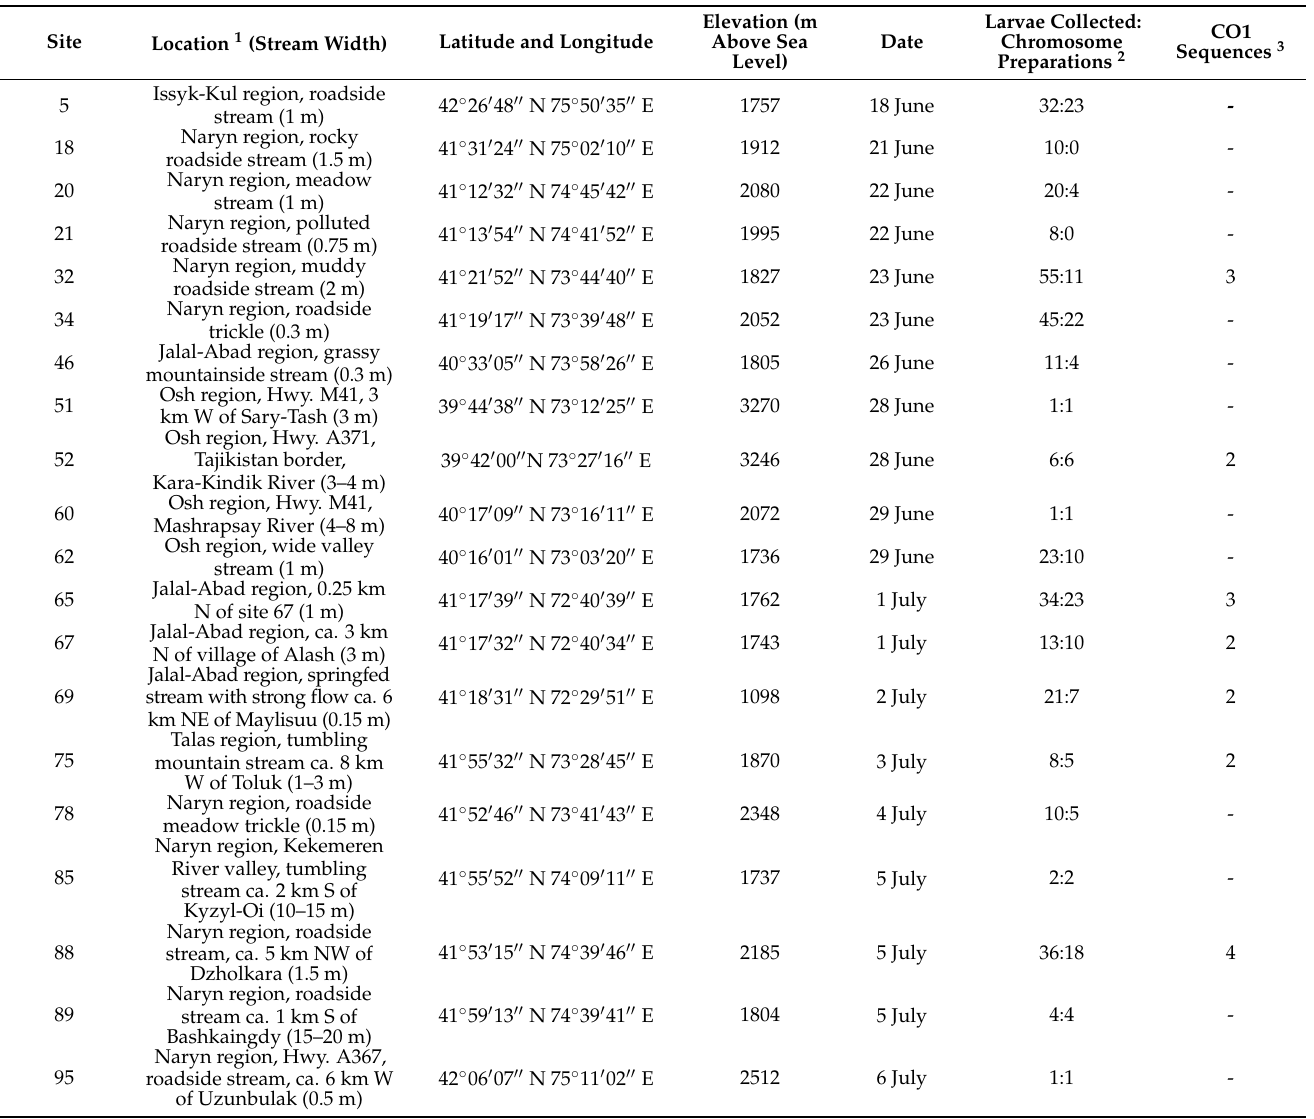
1 Distances are along straight lines. 2 Number of larvae collected into 1:3 acetic ethanol fixative and the number prepared chromosomally. Banding patterns from the following prepared larvae could not be completely interpreted due to poor chromosomal quality and are not included in the analyses or Table 2: site 5 (one larva), site 32 (four larvae), site 46 (one larva), site 62 (four larvae), site 65 (one larva), site 69 (five larvae), site 75 (one larva), and site 88 (one larva). 3 A hyphen (-) indicates that no larvae were